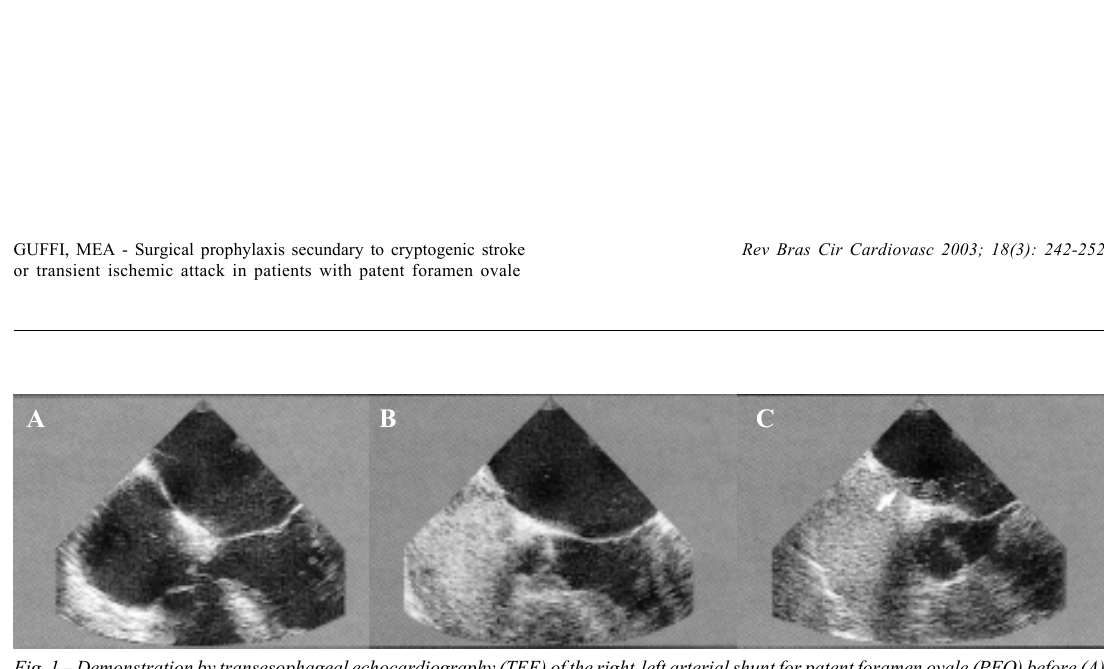
Fig. 1 – Demonstration by transesophageal echocardiography (TEE) of the right-left arterial shunt for patent foramen ovale (PFO) before (A) and after (B, C,) administration of contrast (Echovist) in patient Nº 35 of this series